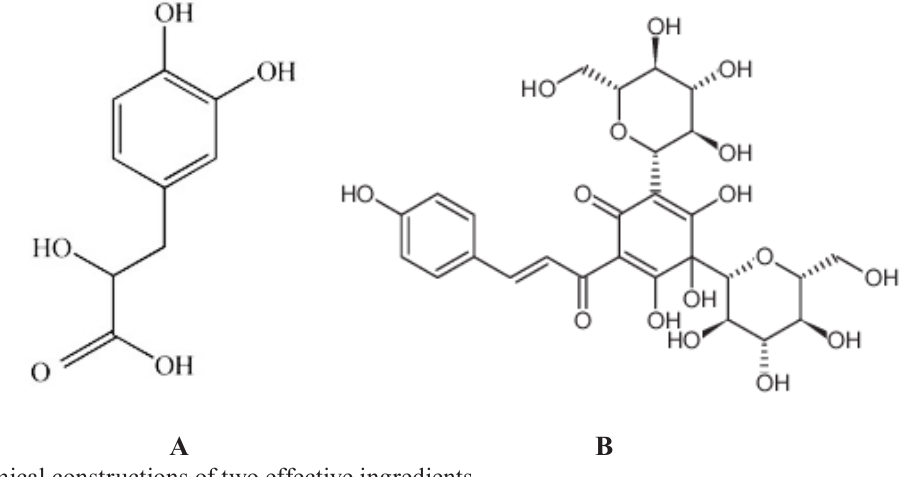
FIGURE 1 - Chemical constructions of two effective ingredients. A: chemical structure of SAA, molecular formula: C B: chemical structure of HSYA, molecular formula: C